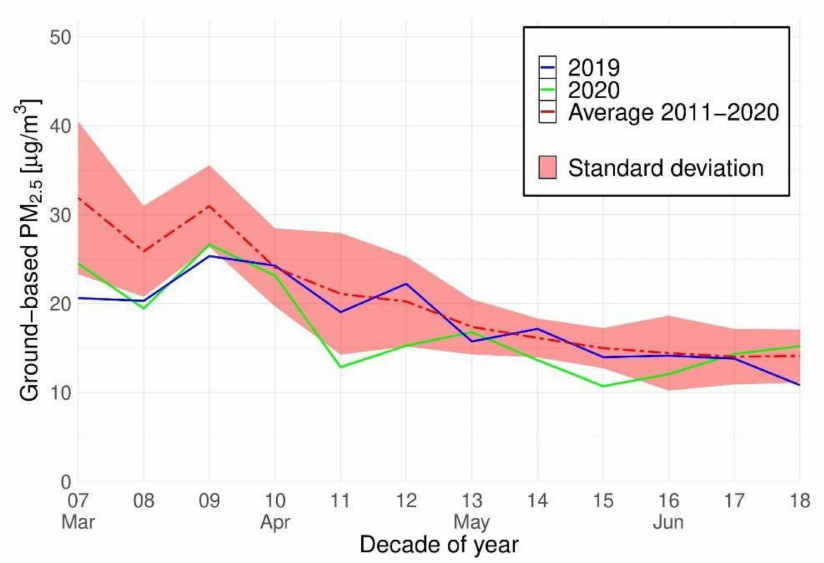
Figure 7. Mean decadal ground-based PM 2.5 concentrations ( µ g/m 3 ) from two GIOS air quality stations located in Warsaw in 2019 (blue line), 2020 (green line) and the 10-year multi-annual averages (dashed red line). Standard deviations corresponding to multi-annual averages are marked in